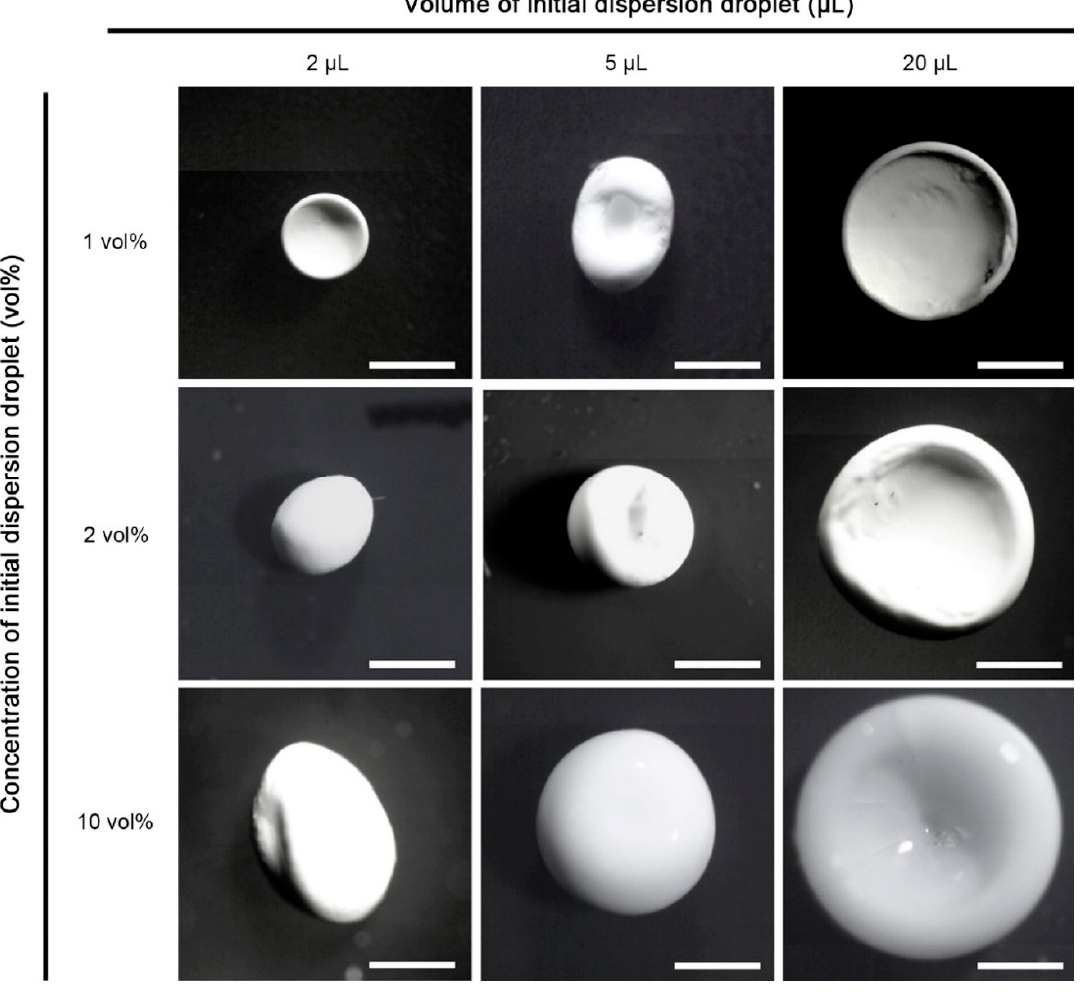
Figure 4. Optical microscopic images of various sizes of silica supraparticles from different spherical NP concentrations (1, 2, 10 vol %) and volume (2, 5, 20 μ L) of initial dispersion drops. The scale bars are 500 μ m.